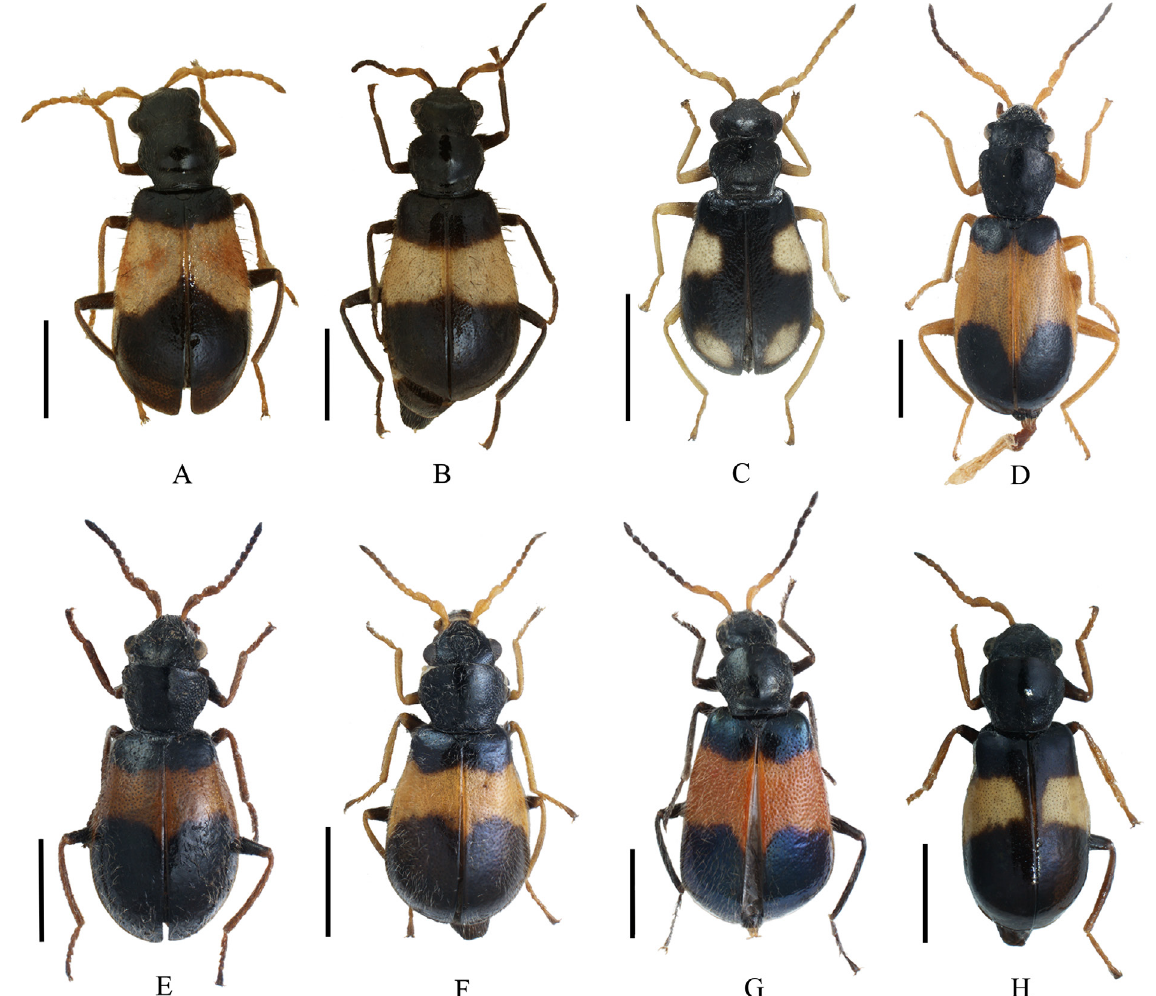
Fig. 2. Dosal habitus of Intybia spp., ♀. A . Intybia histrio (Kiesenwetter, 1874). B . I. tsushimensis (Satô & Ohbayashi, 1968). C . I. donan sp. nov., paratype. D . I. pelegrini pelegrini (Pic, 1910). E . I. niponica (Lewis, 1895). F . I. takaraensis (Nakane, 1955). G . I. kishiii (Nakane, 1955). H . I. kawasakii (Nakane, 1956), paratype. Scale bars = 1.0